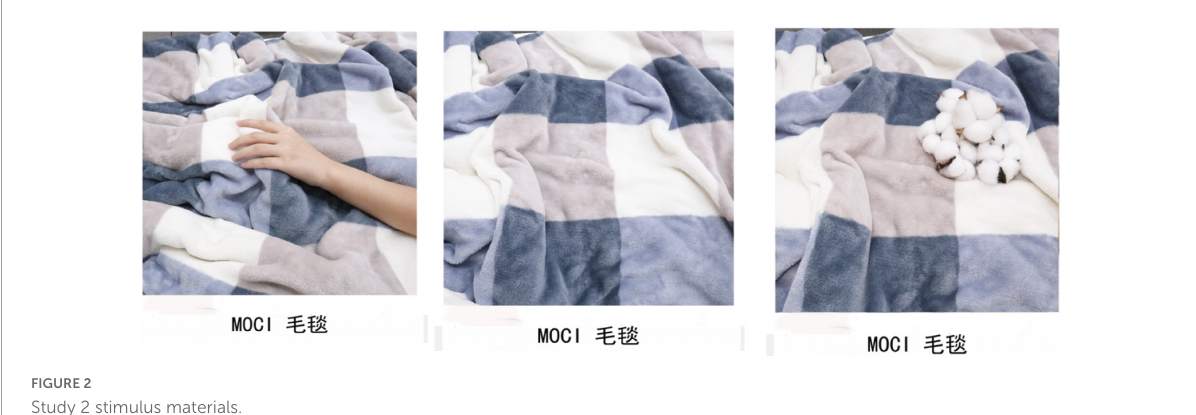
FIGURE2 Study 2 stimulus